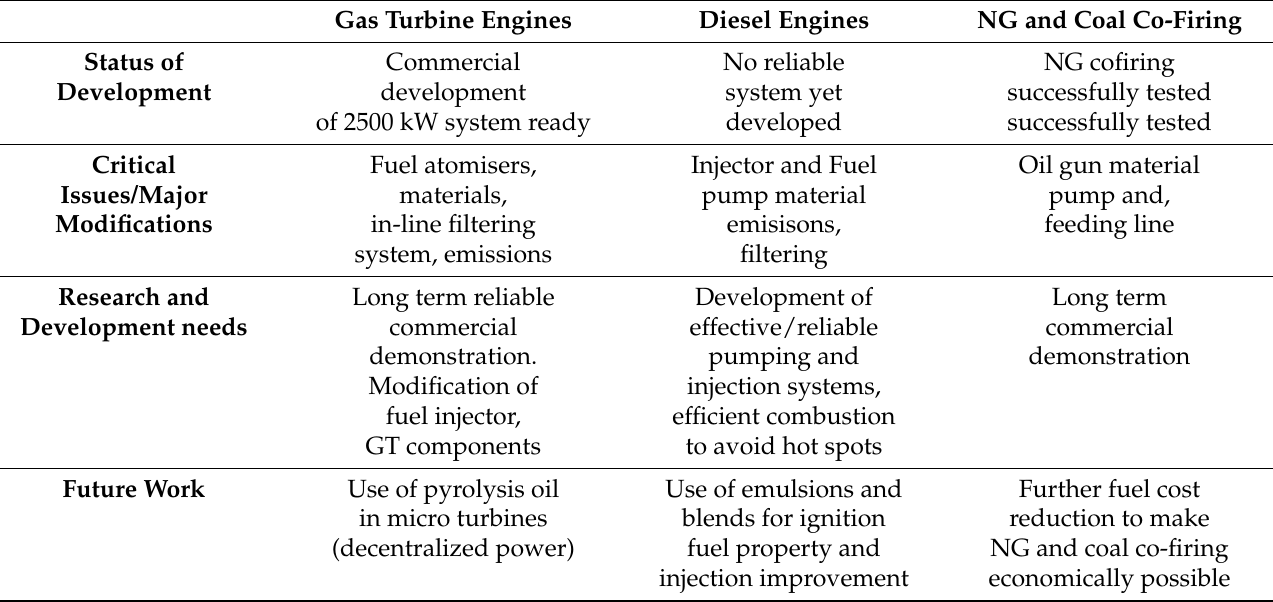
Table 6. Status of using pyrolysis oils in different combustion